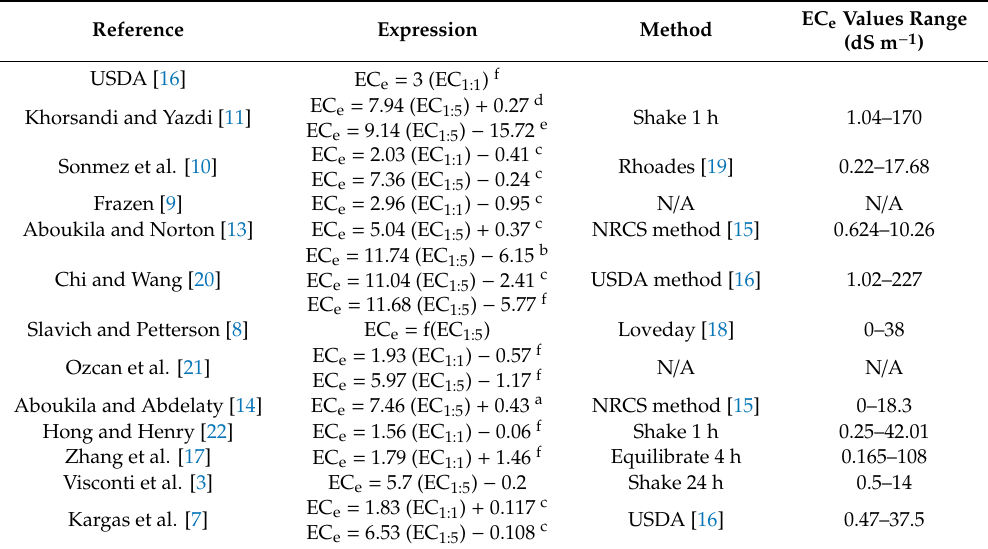
Table 1. Relationships between soil saturated paste extract electrical conductivity (EC e ) and 1:1 and 1:5 soil to water extract electrical conductivities (EC 1:1 , EC 1:5 ) as proposed by several researchers, as well as the extraction method and the corresponding range of EC e